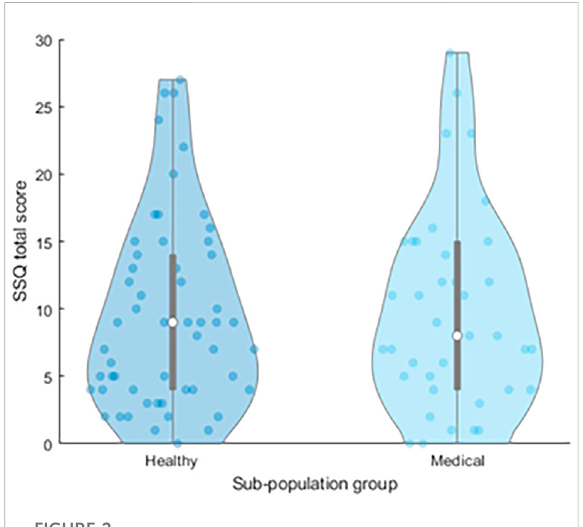
FIGURE 2 DistributionoftotalSSQscoresbysub-population,displaying medianandinterquartileranges.Individualdatapointsareshownin